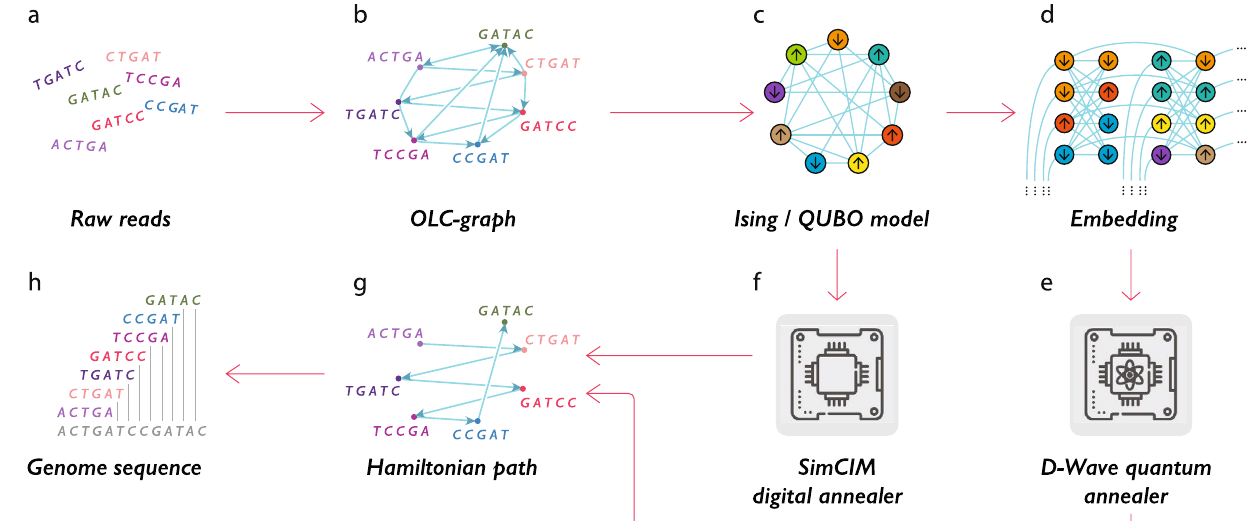
Figure 1. Solving the de novo genome assembly problem using quantum annealers and quantum-inspired (digital) annealing algorithms: ( a ) raw reads; ( b ) raw reads are transformed to the overlap-layout-consensus (OLC) graph; ( c ) finding the Hamiltonian path for the OLC graph is reduced to the QUBO problem; ( d ) the QUBO problem should be embedded to the architecture of the quantum annealer (D-Wave): for this purpose each logical variable of the the QUBO problem is assigned with several qubits of the quantum annealer; ( e ) and ( f ) the Ising problem in QUBO form can be solved using quantum annealers (D-Wave) and quantum-inspired algorithms (SimCIM), correspondingly; ( g ) the output is the Hamiltonian path; ( h ) the genome sequence is obtained as the